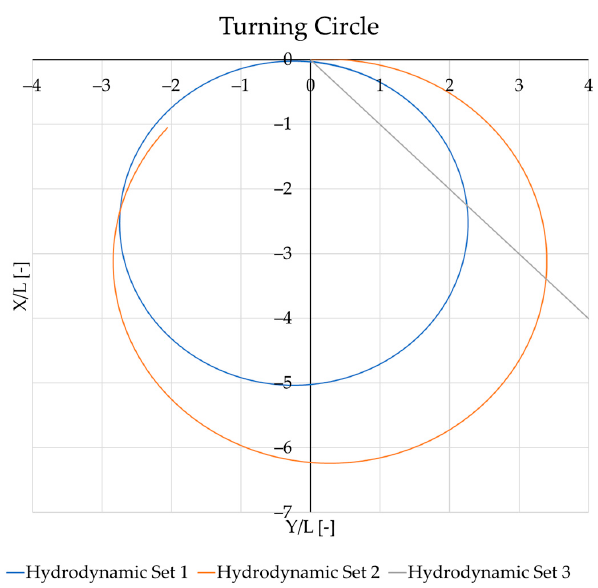
Figure 8. Turning circle test: Normalised displacement over a ship length in global CS.